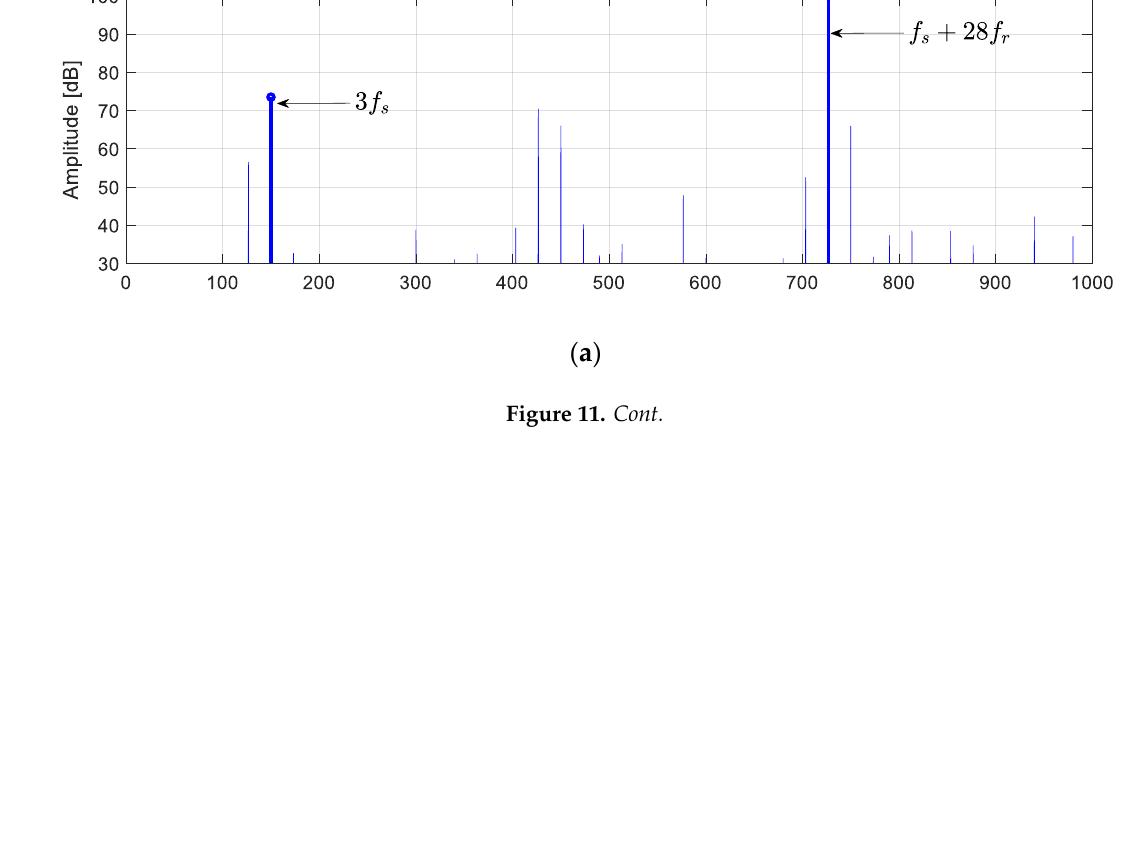
Figure 10. Modeling of eccentricity.